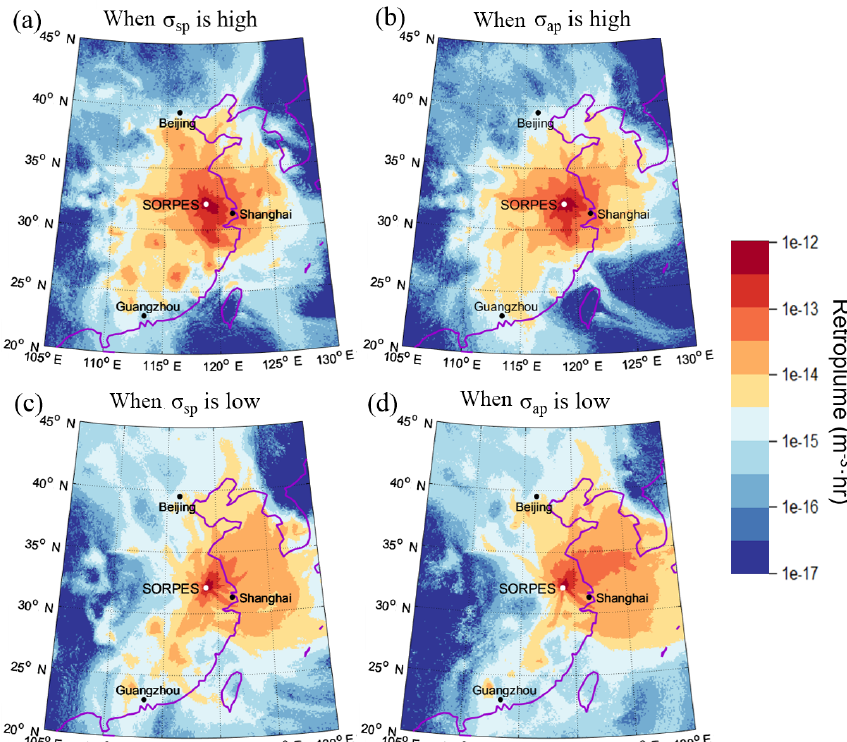
Figure 7. Averaged 72h retroplumes for the highest 10% of daily averages of (a) σ sp and (b) σ ap of each month and for the lowest 10% of daily averages of (c) σ sp and (d) σ ap of each month. The calculation of the retroplumes is described in Sect.